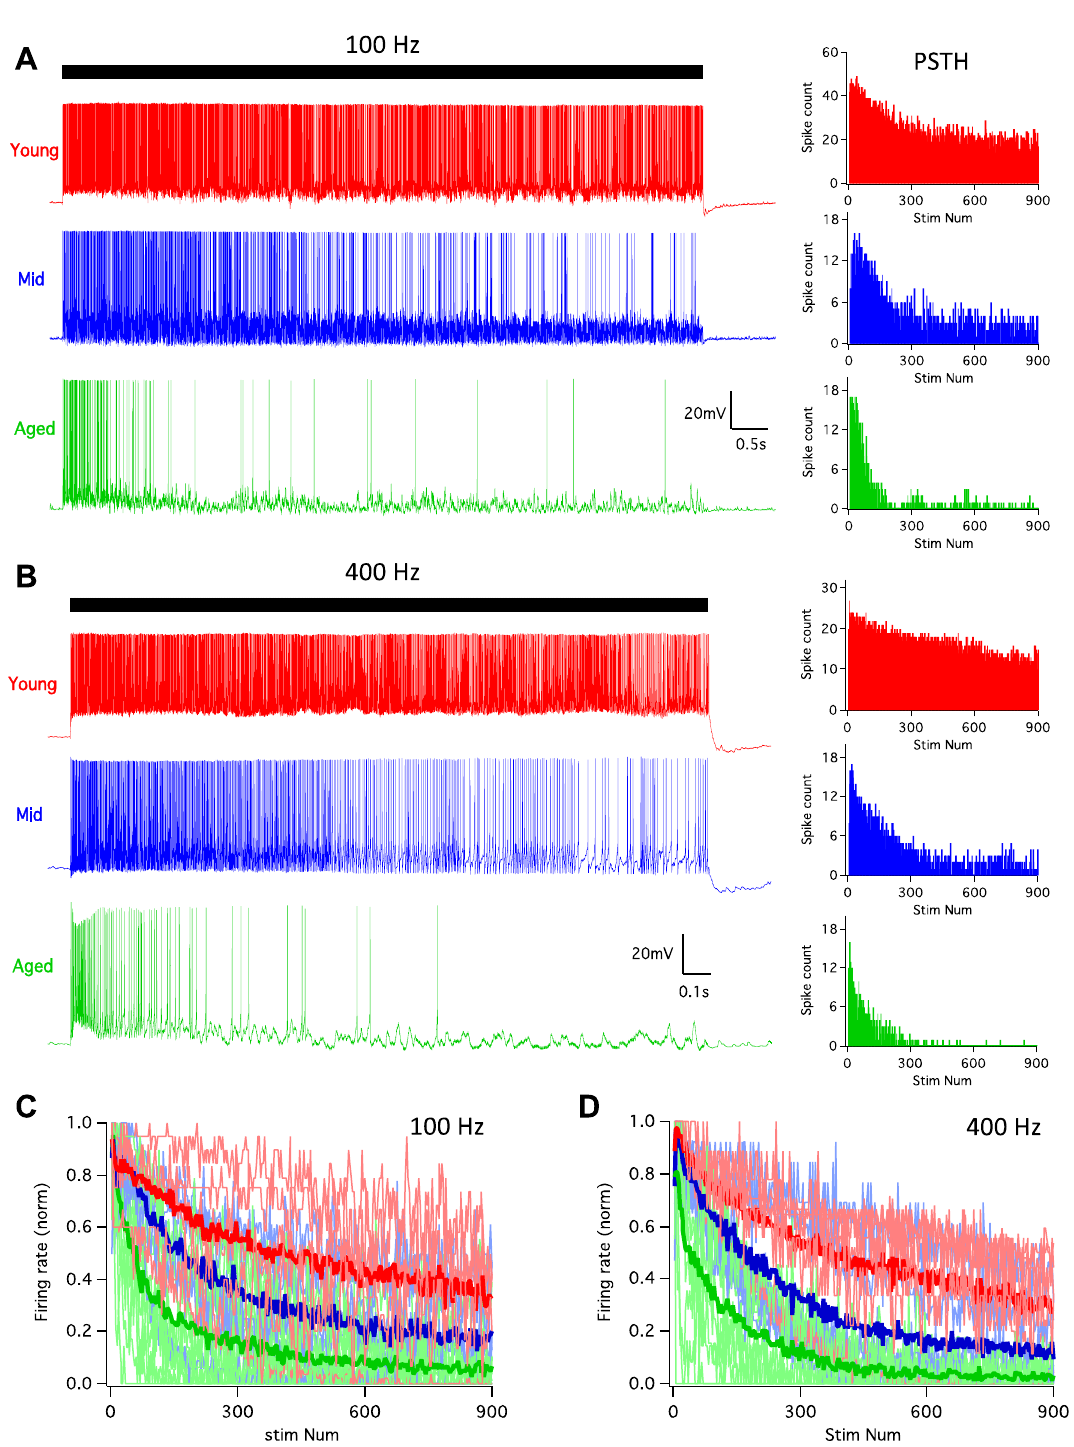
Figure 3. D-stellate neurons decrease in firing rate to auditory nerve inputs during aging. ( A ) Left: example responses of D-stellate neurons to auditory nerve inputs at 100 Hz. Ticks on top mark the timing of 900 stimuli at the auditory nerve. Note the decreased firing of spikes in middle and aged cells. Right: PSTH plots of the responses from the cells in left panels. ( B ) Same as in ( A ) except that the stimulus trains were at 400 Hz. ( C ) Normalized firing rate to 100 Hz stimulus trains in all D-stellate neurons from three age groups. Thin lines: individual neurons; thick lines: average firing rate in three age groups. ( D ) Normalized firing rates to 400 Hz stimulus trains.